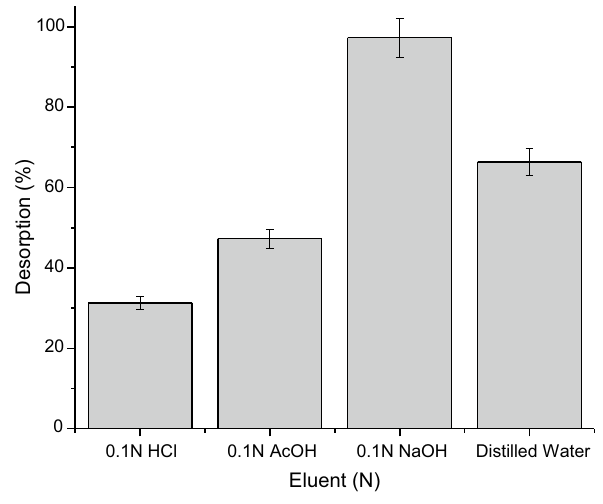
Fig. 10 Desorption of Congo red by different eluents